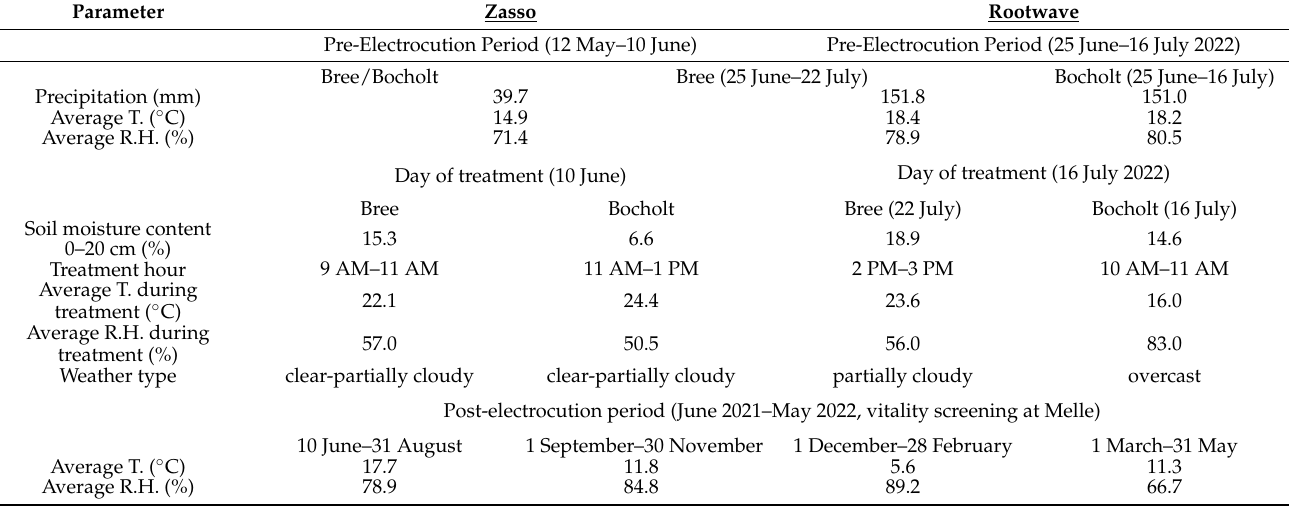
Table 2. Climatic and pedohydrological parameters (in 2021 and 2022) before, during, and af- ter the Zasso and Rootwave electrocution treatments in Bree and Bocholt. T. = temperature ( ◦ C), R.H. = relative humidity (%). The meteorological data were obtained via the KMI (Royal Meteorolog- ical Institute of